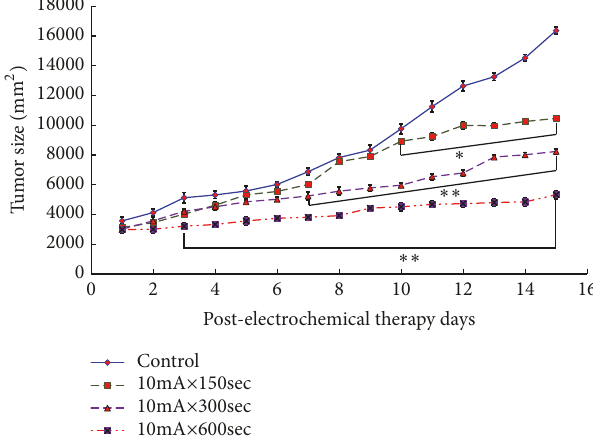
Figure 3: Changes of the tumor volume after Sarcoma-180 inocu- lation in the groups of control, 10mA × 150sec, 10mA × 300sec, and 10mA × 600sec ( ∗ p < 0.05 , ∗∗ p < 0.01 ). The results represent ± S.D. from 8 to 10